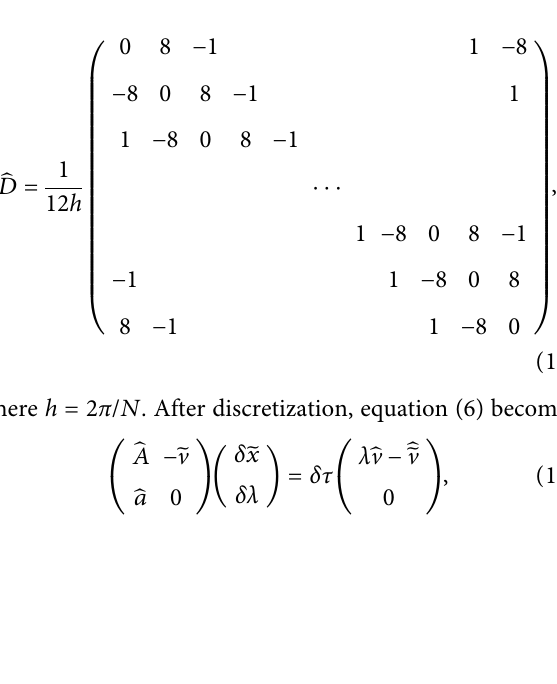
Figure 4: First return map for Poincar´e section: (a) z � 6 . 7, ( a, b ) � ( 2 , 6 , 7 ) and (b) z � 9 . 3, ( a,b ) � ( 2 , 9 . 3 ) .